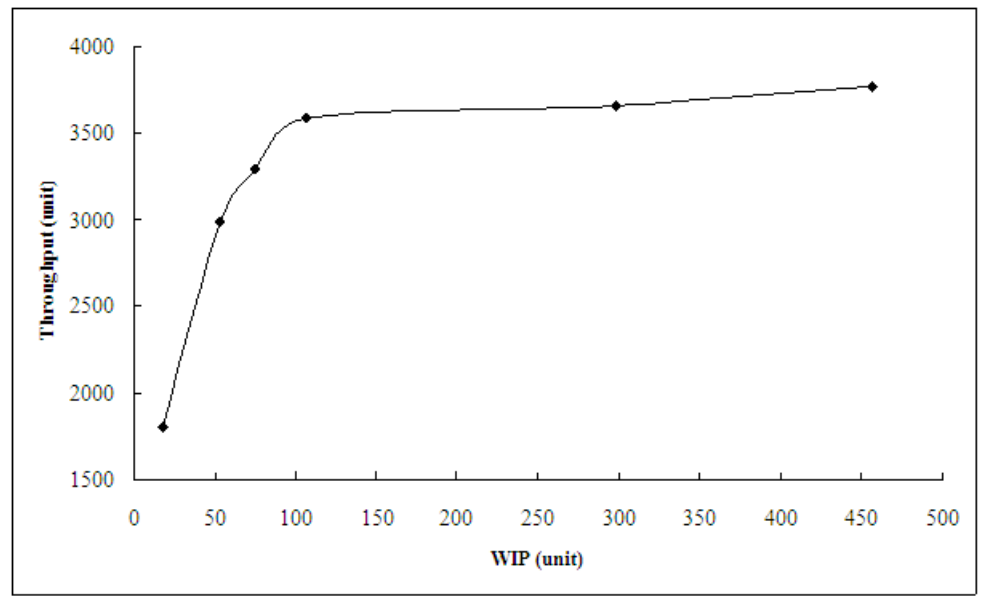
Figure 5. WIP vs. throughput of three lathes and three mills